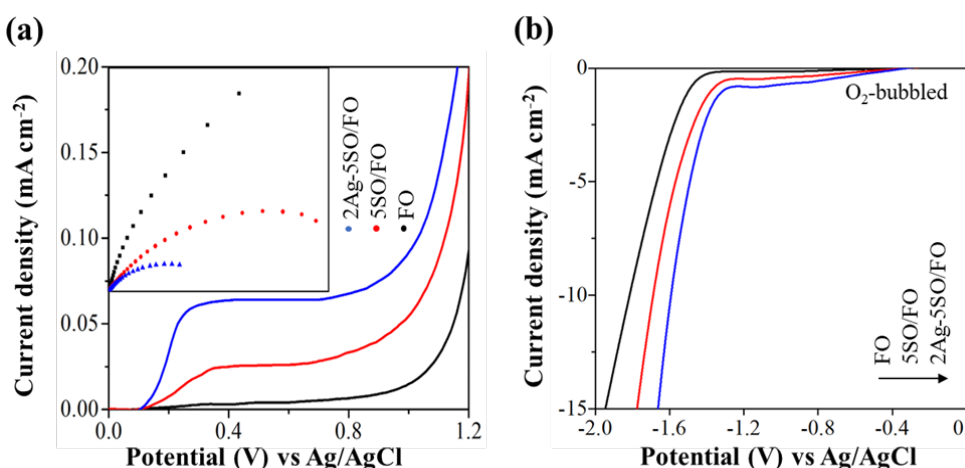
Figure 4. ( a ) Linear sweep voltammetry (LSV) curves, and electrochemical impedance spectra (EIS) Nyquist plots, related to charging separation of FO, 5SO/FO, and 2Ag-5SO/FO (inset); ( b ) Electro- chemical chemical (EC) reduction curves for O 2 -bubbled system of FO, 5SO/FO, and 2Ag-5SO/FO.